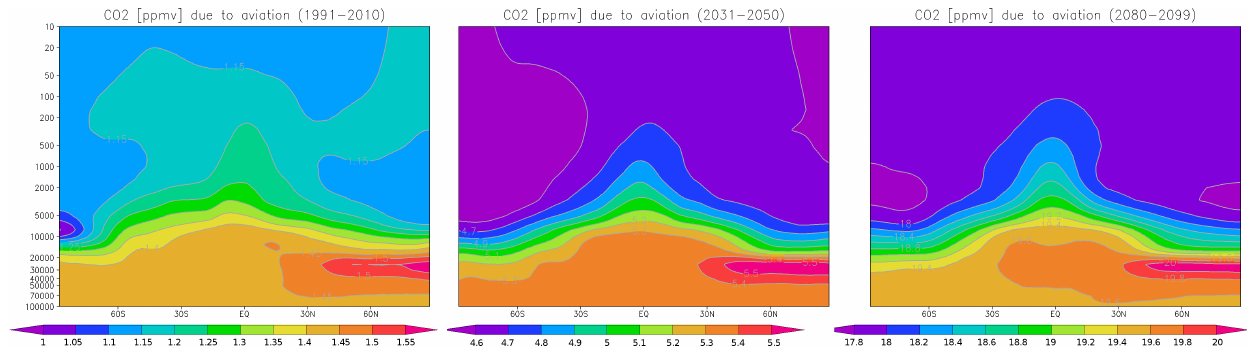
Fig. 7. Impact of aircraft CO 2 emissions on the zonally averaged CO 2 distribution for 1991–2010 (left), 2031–2050 (middle) and 2080–2099 (right) in ppmv. Note that the colorbar is different in each plot. The vertical axis corresponds to pressure in